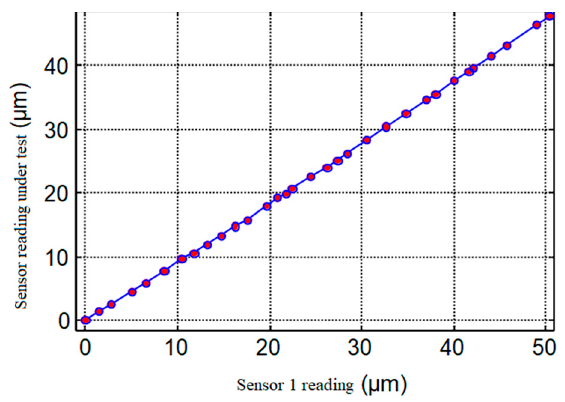
Figure 7. Nonlinear capacitance analysis of displacement sensor.